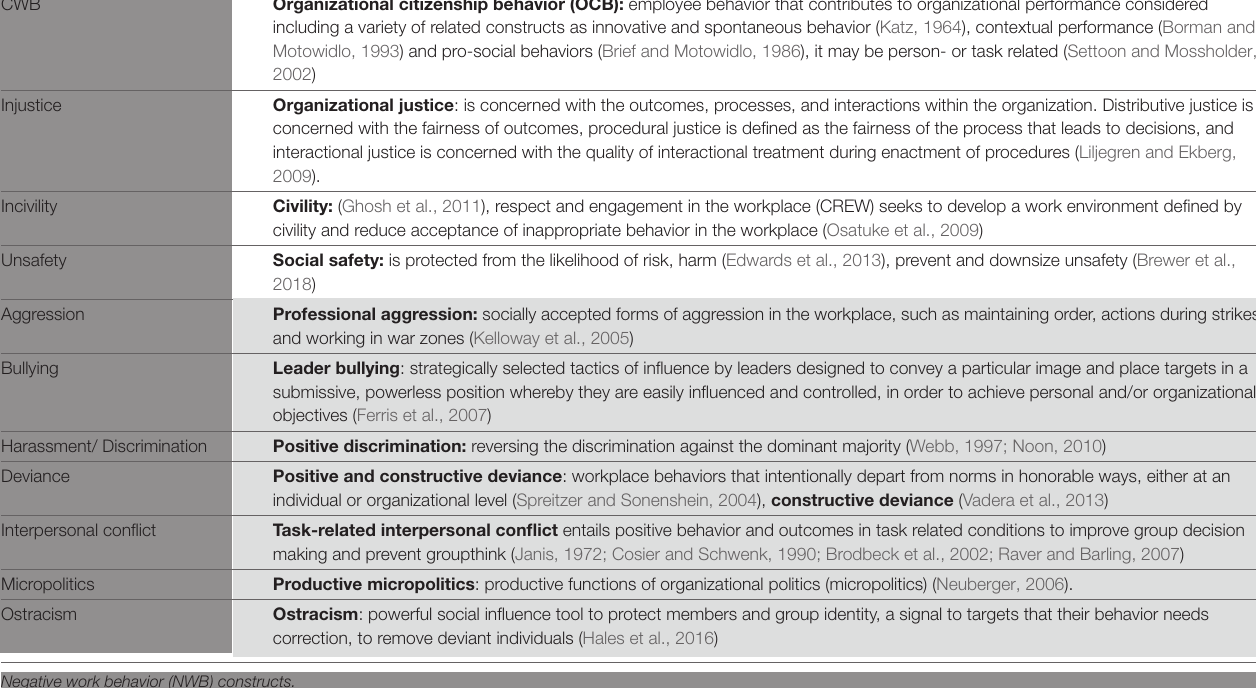
TABLE 2 | Comparison of behavior in PWB and NWB